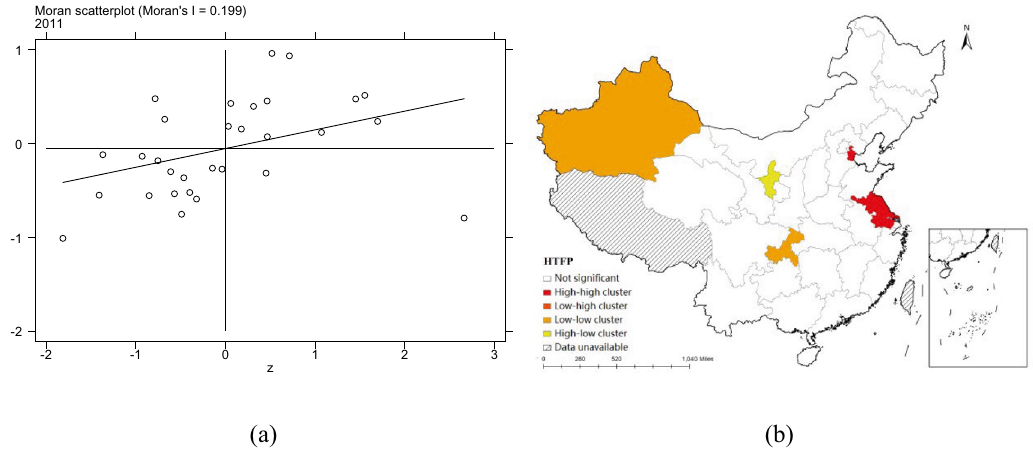
Figure 7. Moran scatter plot and LISA aggregation plot of